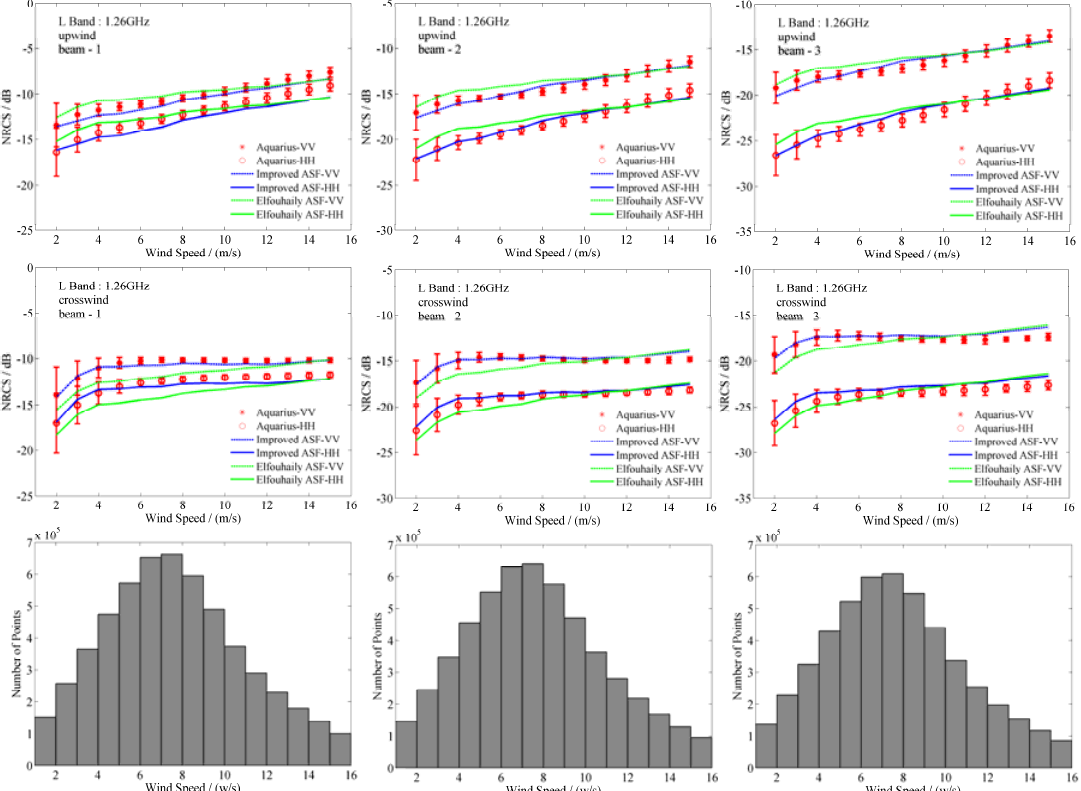
Figure 6. The upper and middle rows show a comparison of NRCSs from model simulations with different ASFs and satellite observations versus wind speed in the upwind and crosswind direction, respectively. The left column corresponds to beam 1, the middle column corresponds to beam 2, and the right column corresponds to beam 3. Here, beam 1, 2 and 3 denote the incidence angles of 28.7 ◦ , 37.8 ◦ and 45.6 ◦ , respectively. Red stars and circles are the binned matchup averages for VV and HH polarization, respectively; vertical bars represent of ± 1 SD matchup data. Dashed lines and solid lines are model simulations for VV and HH polarization, respectively. Green and blue lines denote the model simulations with Elfouhaily’s ASF and our improved ASF, respectively. The bottom row shows the number of data points for calculations at each beam.